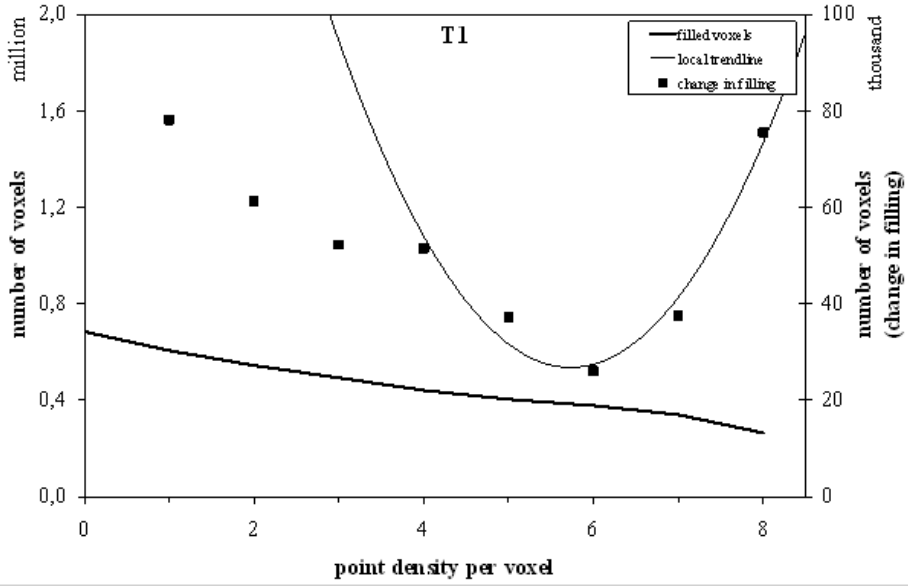
Figure 4. Number of filled voxels (thick line), change of number of filled voxels (dots) and local trend function for change of filled voxels (thin line); the minimum of this function is used to define a threshold of point density per voxel for noise reduction